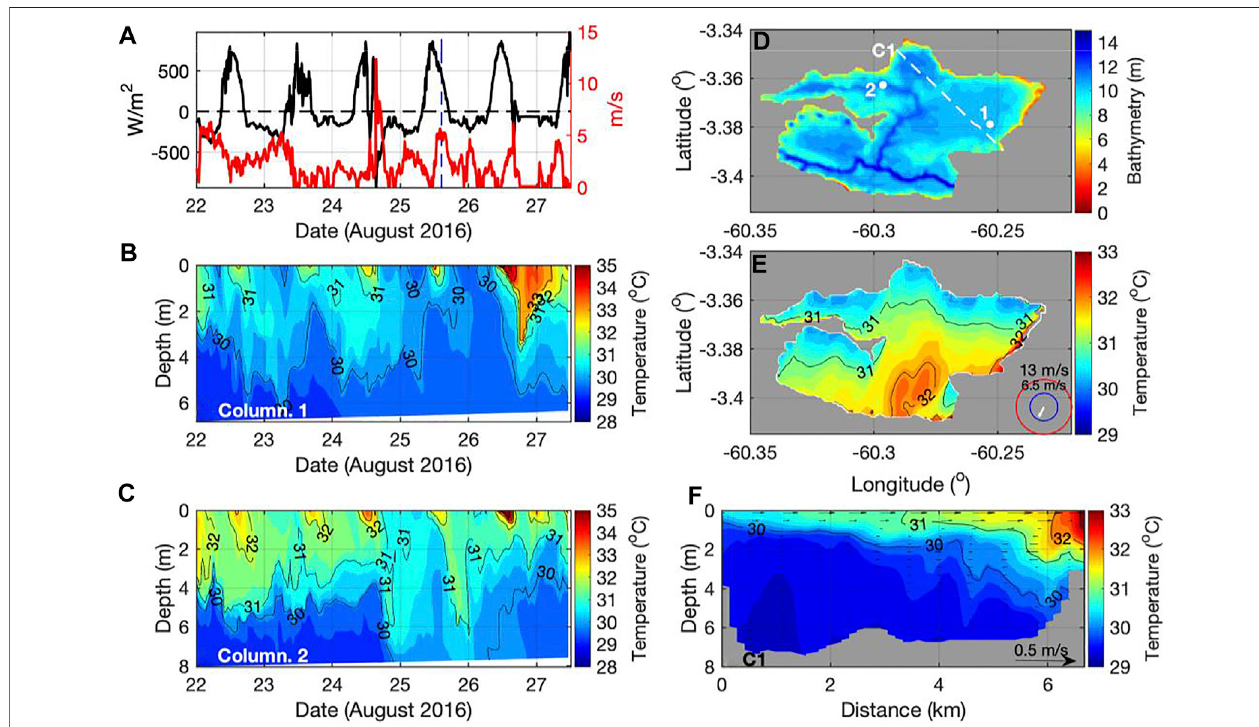
FIGURE 4 | Three-dimensional modeling of thermal structure in Lake Janauacá. (A) The net heat fl ux and wind speed at site one on map in panel d; (B,C) AEM3D simulated temperatures of water column at sites 1,2 over 5 days; (D) bathymetry of Lake Janauacá, white dots indicate sites 1,2 shown in panels b and c, and white dashed line marks orientation of transect C1; (E) AEM3D simulated near-surface temperatures at the time marked by the vertical blue dashed line in panel a (25 August 2016,14:29:30 h); (F) AEM3Dsimulatedtemperaturesand horizontalvelocities along transect C1at the time marked bytheverticalblue dashed linein panela(25 August2016,14:29:30 h).Numberedblacklinesinpanelsb,c,eandfaretheisothermsat1 ° Cintervals.ApplicationofAEM3DtoLakeJanauacáisdescribed inAmaral et al.